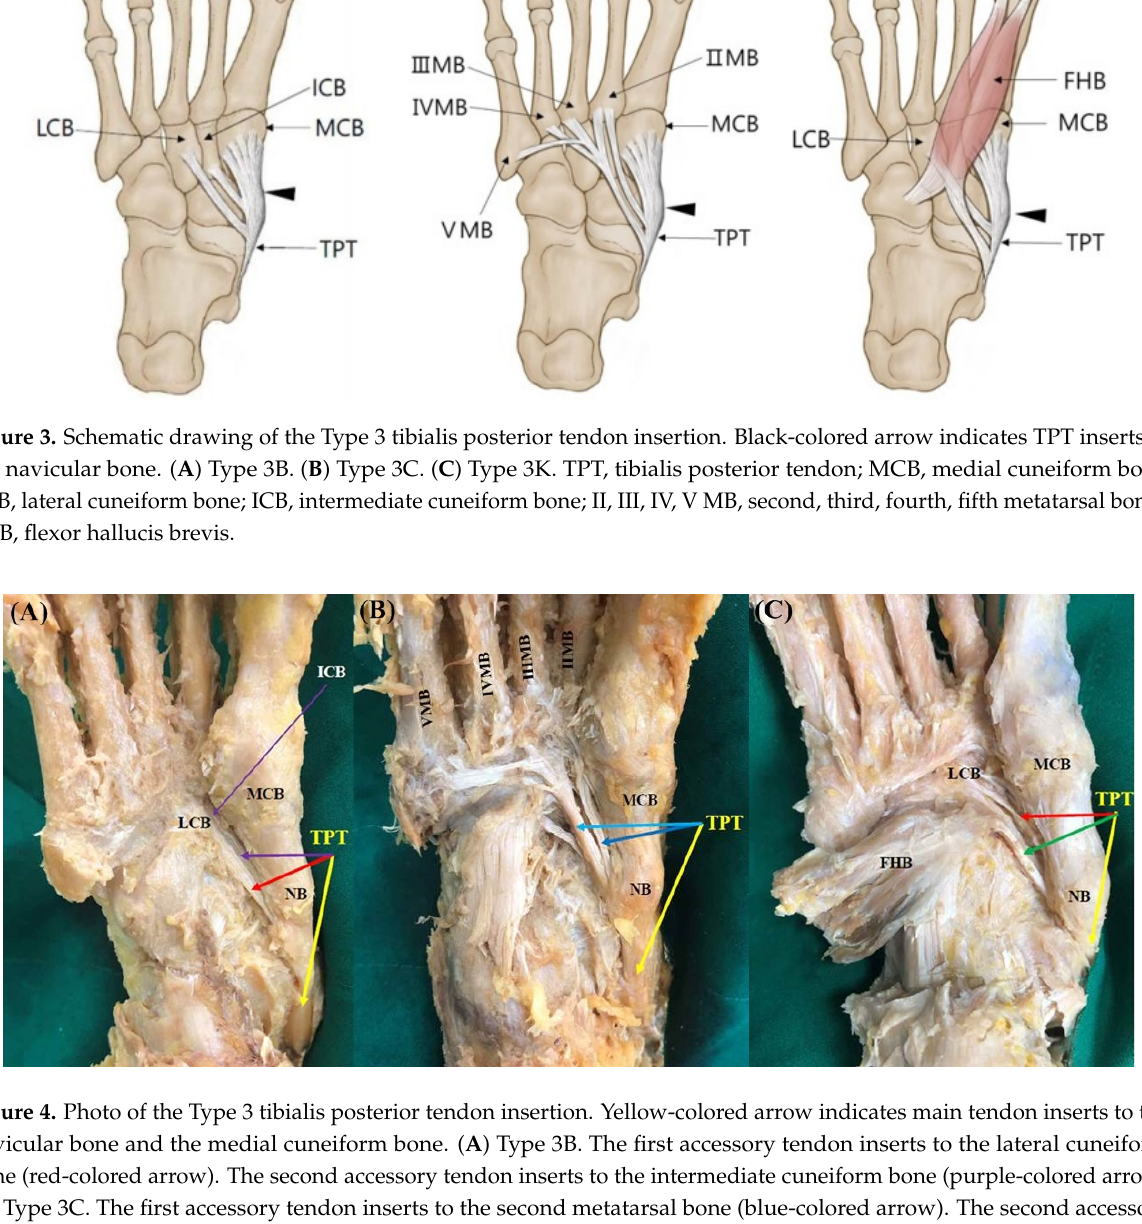
Figure 4. Photo of the Type 3 tibialis posterior tendon insertion. Yellow-colored arrow indicates main tendon inserts to the navicular bone and the medial cuneiform bone. ( A ) Type 3B. The first accessory tendon inserts to the lateral cuneiform bone (red-colored arrow). The second accessory tendon inserts to the intermediate cuneiform bone (purple-colored arrow). ( B ) Type 3C. The first accessory tendon inserts to the second metatarsal bone (blue-colored arrow). The second accessory tendon inserts to the second, third, fourth, fifth metatarsal bones (sky-blue-colored arrow). ( C ) Type 3K. The first accessory tendon inserts to the lateral cuneiform bone (red-colored arrow). The second accessory tendon inserts to medial arm of the fibrotendinous origin of to the flexor hallucis brevis muscle (green-colored arrow). TPT, tibialis posterior tendon; NB, navicular bone; MCB, medial cuneiform bone; LCB, lateral cuneiform bone; ICB, intermediate cuneiform bone; II, III, IV, V MB, second, third, fourth, fifth metatarsal bones; FHB, flexor hallucis brevis.